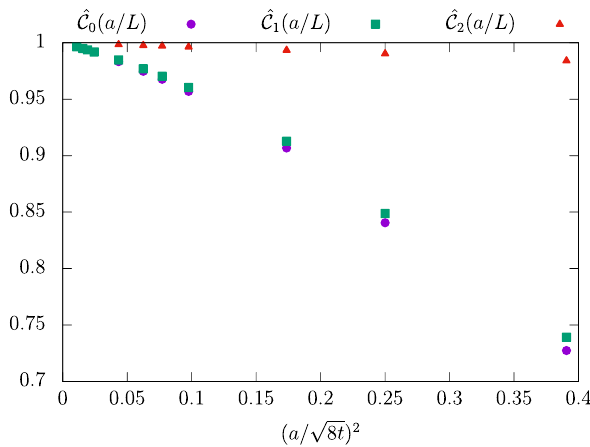
√ 8 t ) ), √ √ 8 t ) ) and J 2 (see ˆ C 2 ( a / 8 t ) ).